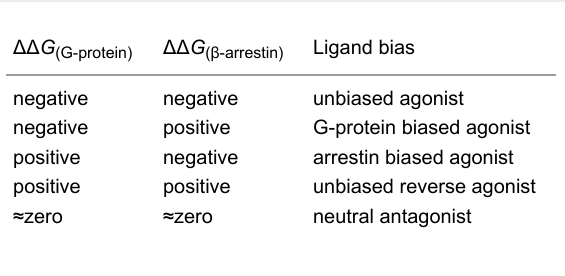
Table 1: Scheme for determining the bias of GPCR ligands according to the calculated changes in ligand-binding free energies [39].